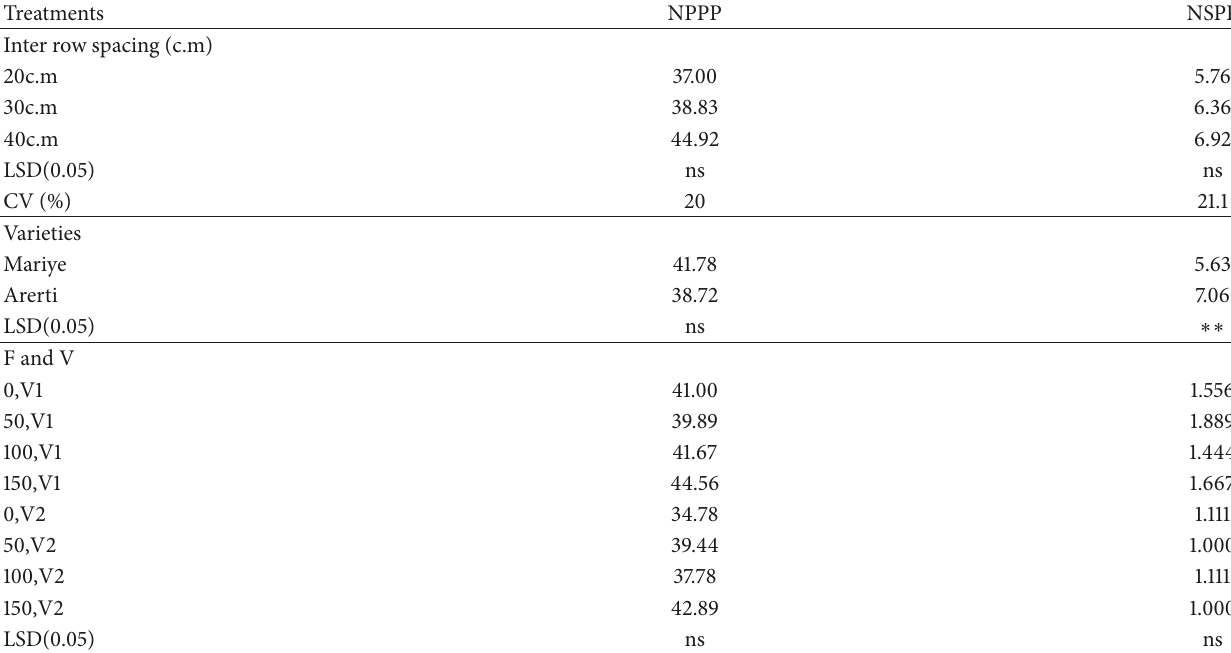
Table 4: Chickpea biomass yield, grain yield, straw yield, hundred-seed weight, and harvest index as influenced by main effect of interrow spacing, variety, and interaction effect of blended fertilizer rates and varieties. Treatments Inter row spacing (c.m) 20c.m